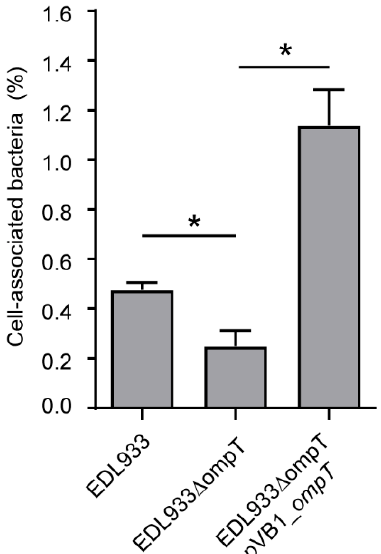
Figure 6. Participation of the OmpT protein in the adhesion of STEC O157:H7 str. EDL933 to HT-29 cells. Data are expressed as percentage of adhesion compared to total bacteria present after 3 h of infection at a multiplicity of infection (MOI) of 10 bacteria per cell. Error bars represent SD. ( n = 3). * p < 0.05 by Student’s t-test (two-tailed) relative to the EDL933 strain.